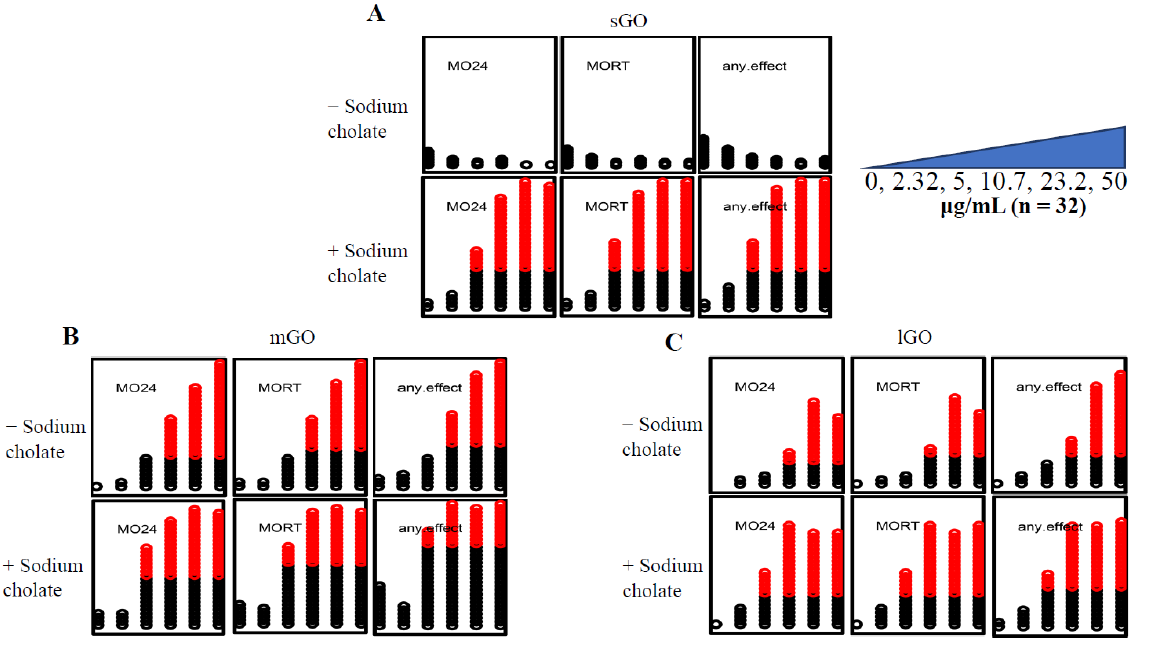
Figure 2. Comparison of GOs with and without sodium cholate. The GO concentration gradient increases from left to right (0 µ g/mL, 2.32 µ g/mL, 5 µ g/mL, 10.7 µ g/mL, 23.2 µ g/mL, 50 µ g/mL), each concentration contained dechorionated embryos ( n = 32) exposed for 120 h. MO24 = 24 hpf mortality; MORT = 120 hpf mortality; any.effect = physical malformations, including mortality at 120 hpf. Outcomes significantly above the binomial threshold (Student’s t -test; α = 0.05) are indicated in red on the dot plot. ( A ) sGO exposures show an increase in mortality upon addition of sodium cholate. ( B ) mGO exposures show an increase in mortality when sodium cholate was added to the solution. ( C ) Addition of sodium cholate to lGO (lGOC) had a wider range of mortality compared to lGO (without sodium